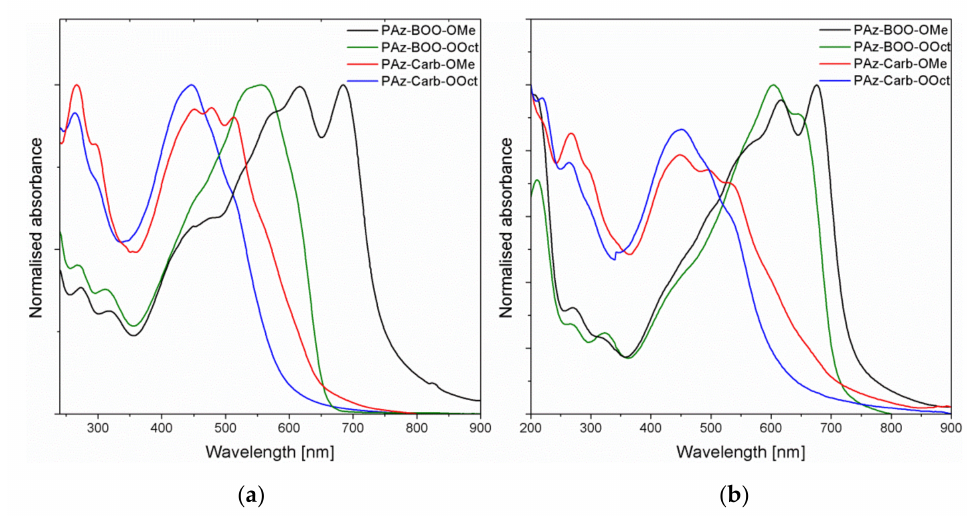
Figure 4. ( a ) Normalized absorbance of investigated oligo- and polyazomethines solutions in chloro- form and ( b ) their thin films, deposited on quartz substrates.